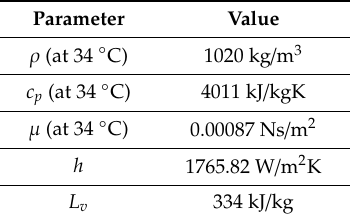
Table 2. Seawater thermophysical properties at 34 ◦ C.